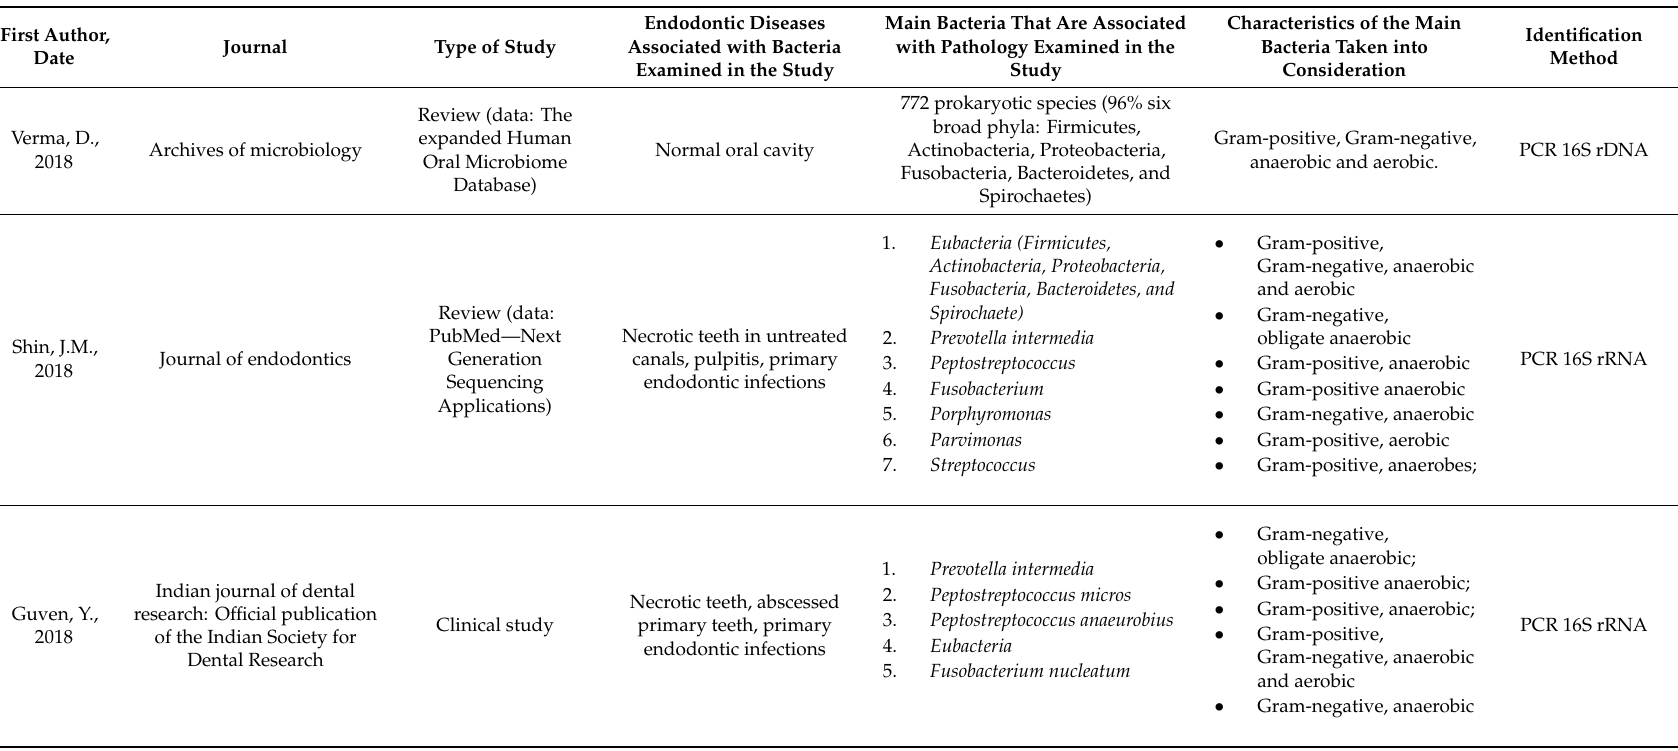
Table 3. The complete list of the nine articles eligible for the qualitative analysis with descriptions of their topics and results. The nine articles were selected from 350 potentially eligible articles and selected by two di ff erent reviewers. The choice of these nine articles reflects the inclusion and exclusion criteria. The most up-to-date and relevant articles for the topic of interest of the review were chosen, articles in doubt for the individual reviewer or in disagreement were excluded from the